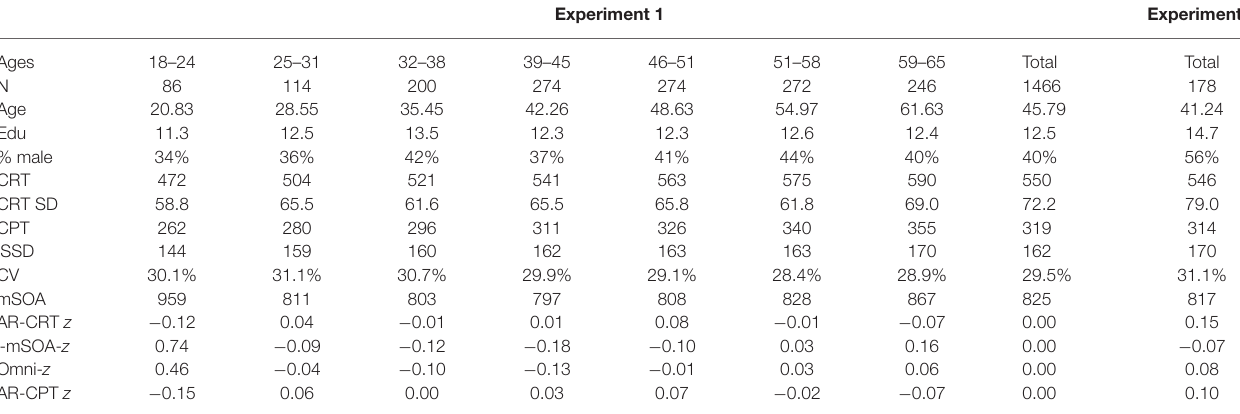
TABLE 2 | Performance of subjects in the seven different age groups in Experiment 1